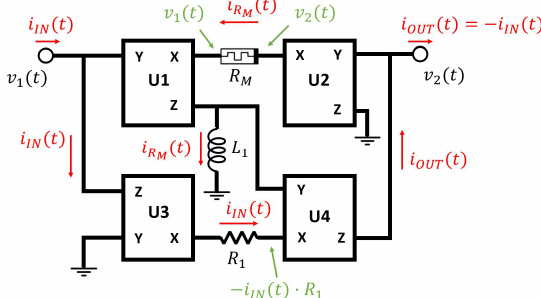
Figure 6. Memcapacitor emulator circuit proposed by Pershin and Di Ventra [45].